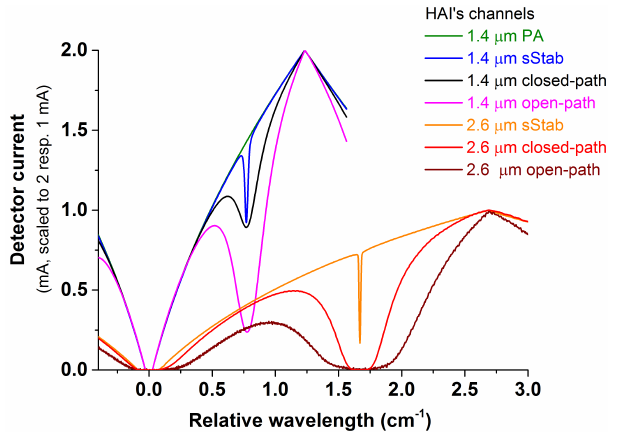
Figure 6. dTDLAS raw signals (spectra) of all seven spectroscopic channels permanently acquired and saved by HAI. The x axis is al- ready converted to the wavelength axis via the individual dynamic tuning rate of each laser. Each spectrum contains approximately 170016bit values (PA: parasitic absorption; sStab: spectral stabi-